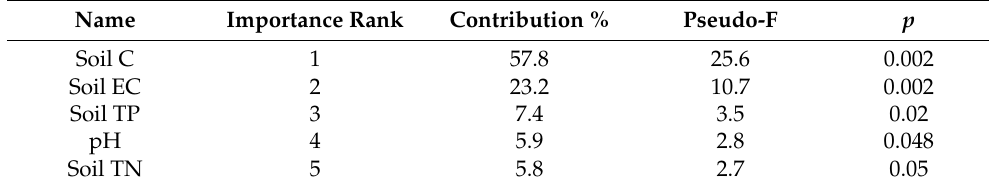
Table 3. Results of the importance ranking and significance tests of the overall soil factors’ variables